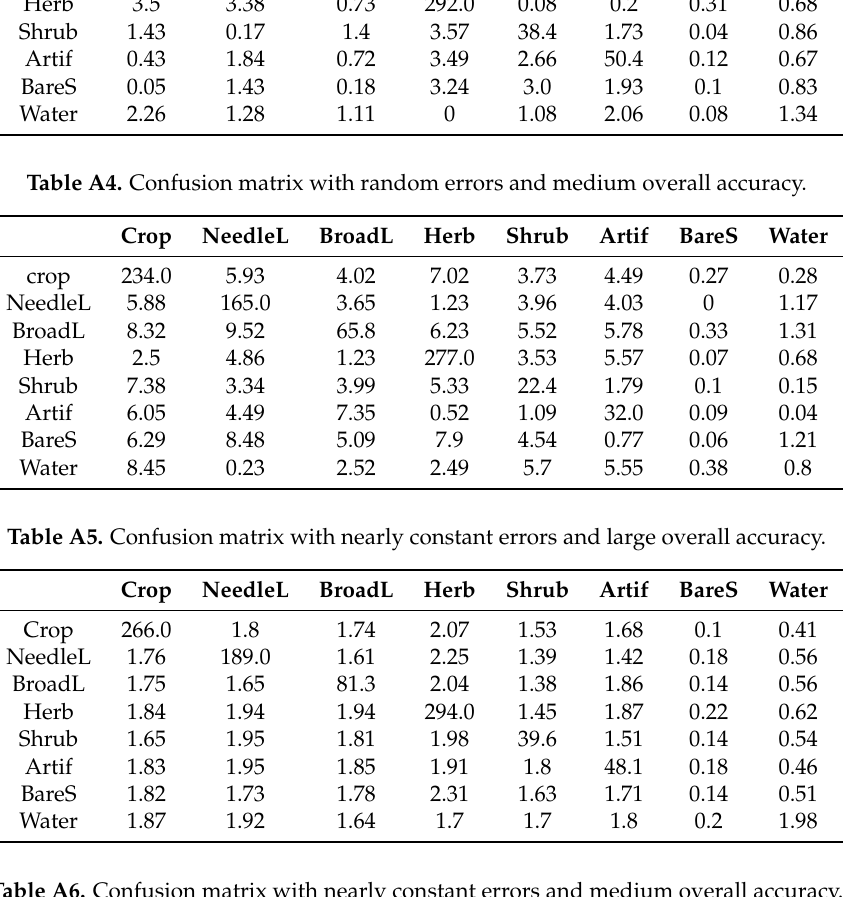
Table A6. Confusion matrix with nearly constant errors and medium overall accuracy. Crop NeedleL BroadL Herb Shrub Artif BareS Water